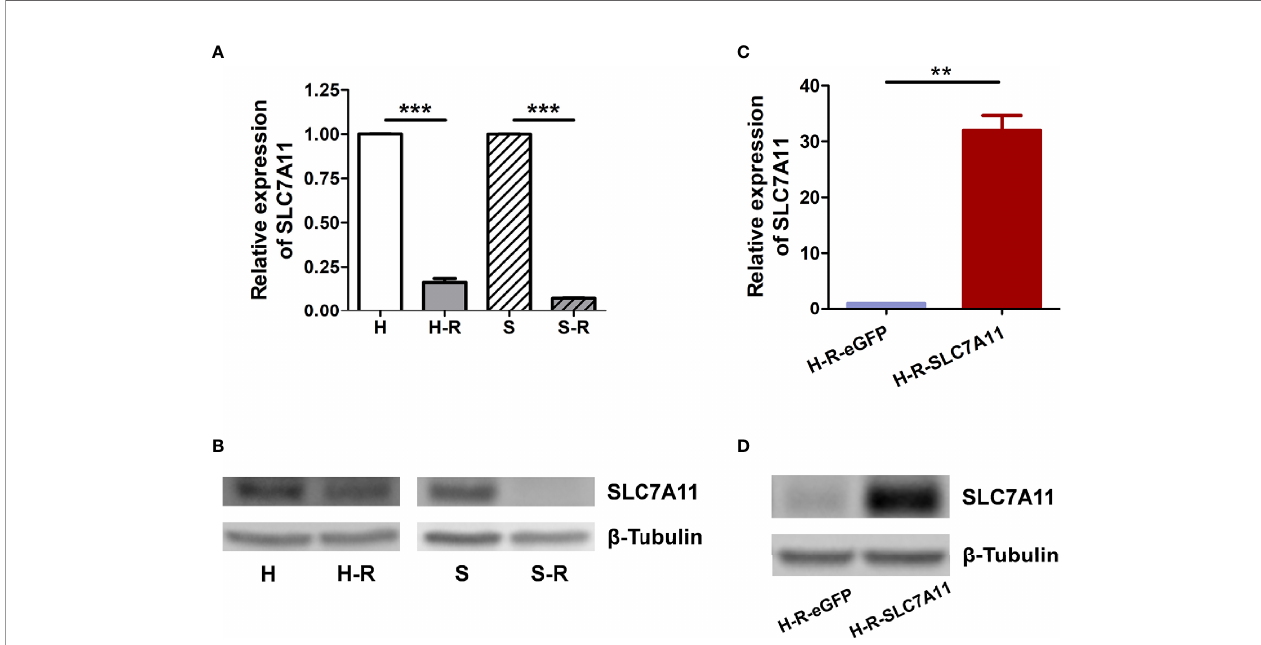
FIGURE 3 | Expression of SLC7A11 in ovarian cancer cell lines. (A) RT-qPCR analysis of SLC7A11 mRNA levels in paclitaxel resistant cells HeyA8-R (H-R), SKOV3-R (S-R) and their parental cells HeyA8 (H), SKOV3 (S); (B) Western blotting analysis of SLC7A11 expression levels in H-R, H, S-R and S cells; (C) Analysis of SLC7A11 mRNA expression in SLC7A11-overexpressed HeyA8-R-SLC7A11 (H-R-SLC7A11) cells and the control HeyA8-R-eGFP (H-R- eGFP) cells by RT-qPCR; (D) Western blotting analysis of SLC7A11 expression levels in HeyA8-R-SLC7A11 (H-R-SLC7A11) cells and the control HeyA8-R- eGFP (H-R-eGFP) cells. Values represent the mean ± SD (** P < 0.01; *** P <